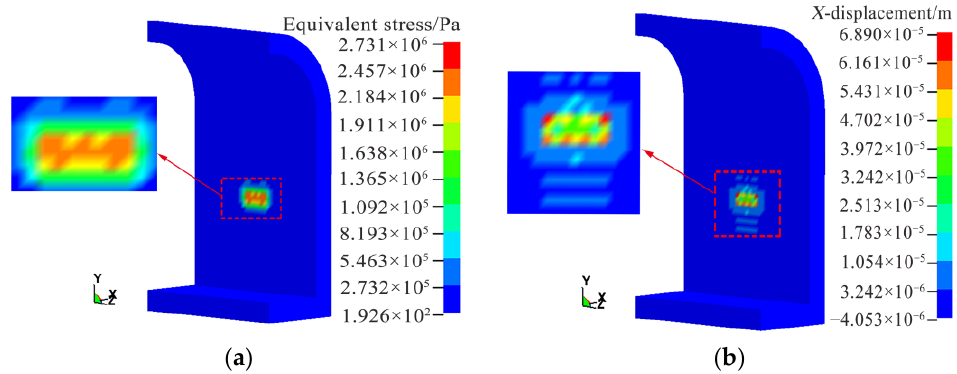
Figure 15. Cross section of city gate tunnel. ( a ) Equivalent stress peak value. ( b ) Peak displacement in X -direction.